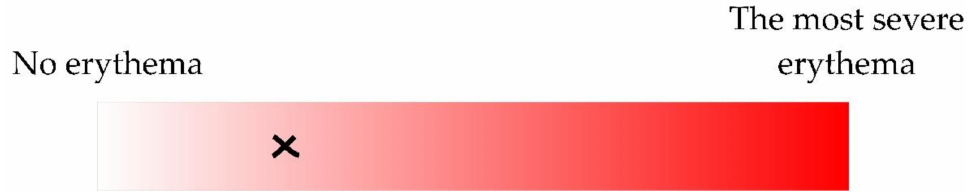
Figure 2. The severity of erythema was estimated according to the continuous scale (manual valuation was transformed to a percentage; 0–100%). The example of an erythema estimation (25.07%) is shown as a cross.